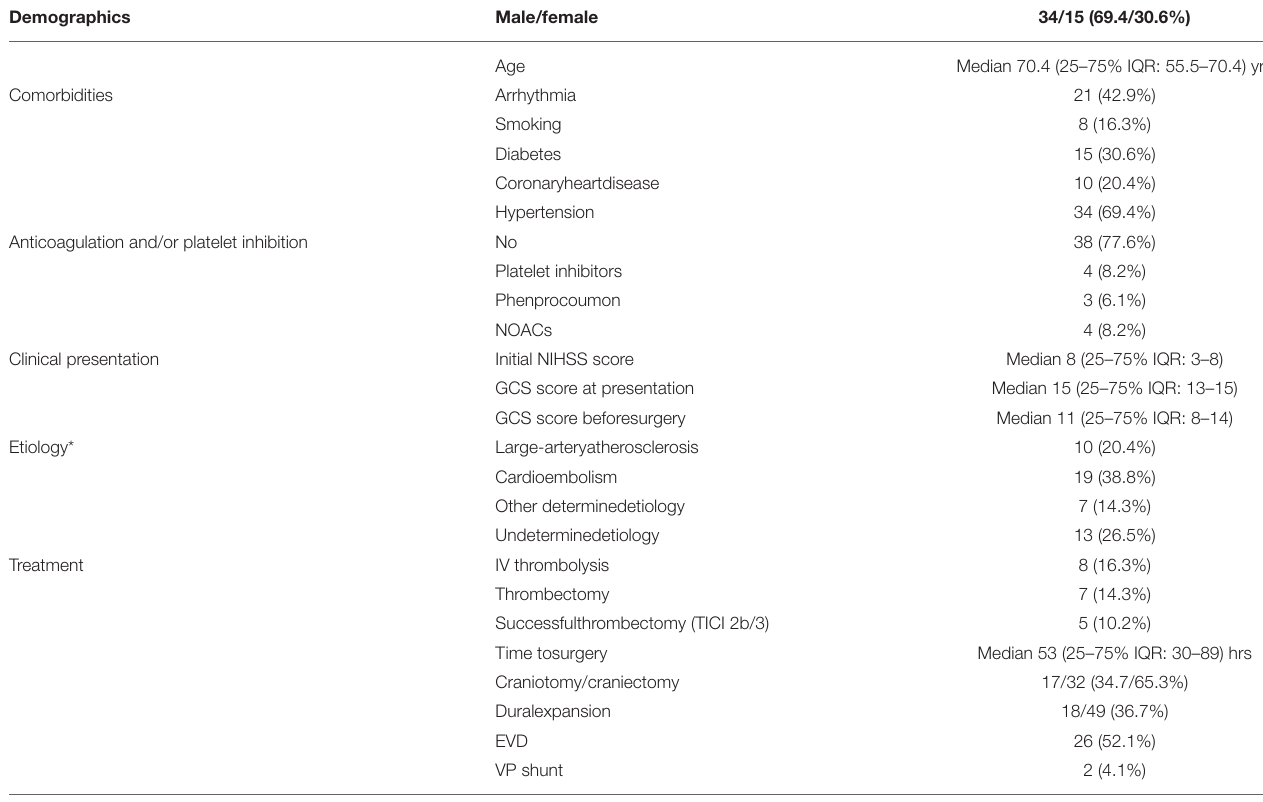
TABLE 1 | Baseline clinical and treatment characteristics ( n = 49).